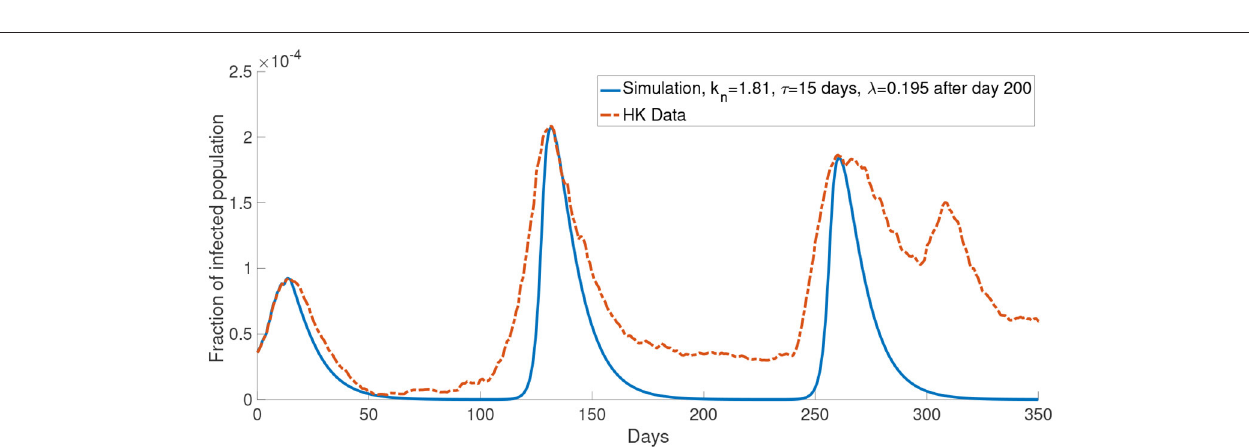
Frontiers in Public Health |